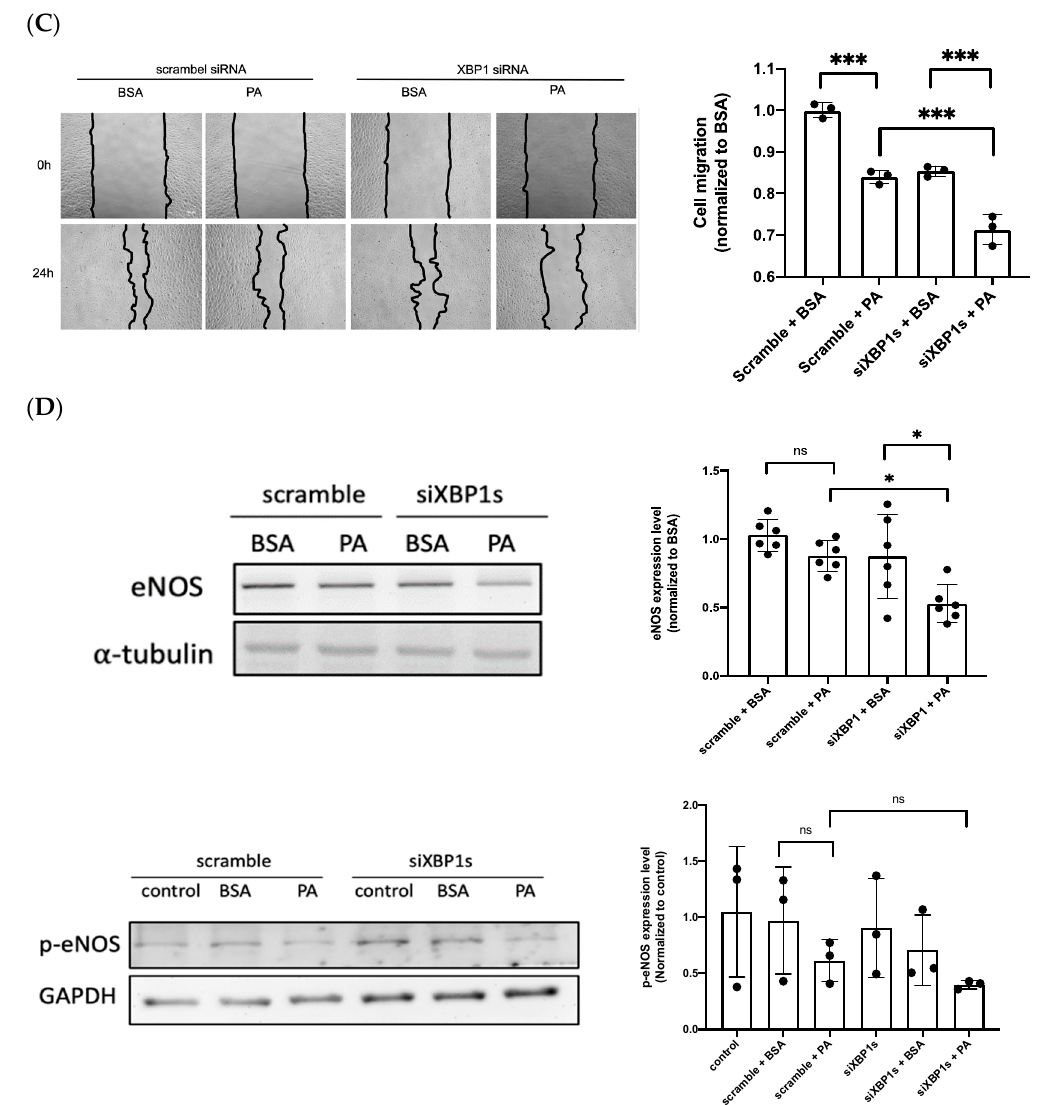
Figure 3. The IRE1 α –XBP1 axis protects endothelial dysfunction in PA-exposed cells. The silencing of XBP1s by siRNA was analyzed using ( A ) qRT-PCR and ( B ) Western blotting. ( C ) The wound healing assay was observed at 0 h and 24 h post-scratching after silencing XBP1s under PA treatment (scale bar: 100 μ m). ( D ) Protein expression of eNOS, p-eNOS after the silencing of XBP1s. Data are presented as the mean ± SEM, and the images are representative of three independent groups. Data from multiple groups were analyzed by one-way ANOVA, followed by Tukey’s post hoc test. * p < 0.05, *** p < 0.001, **** p < 0.0001, respectively. ns: not